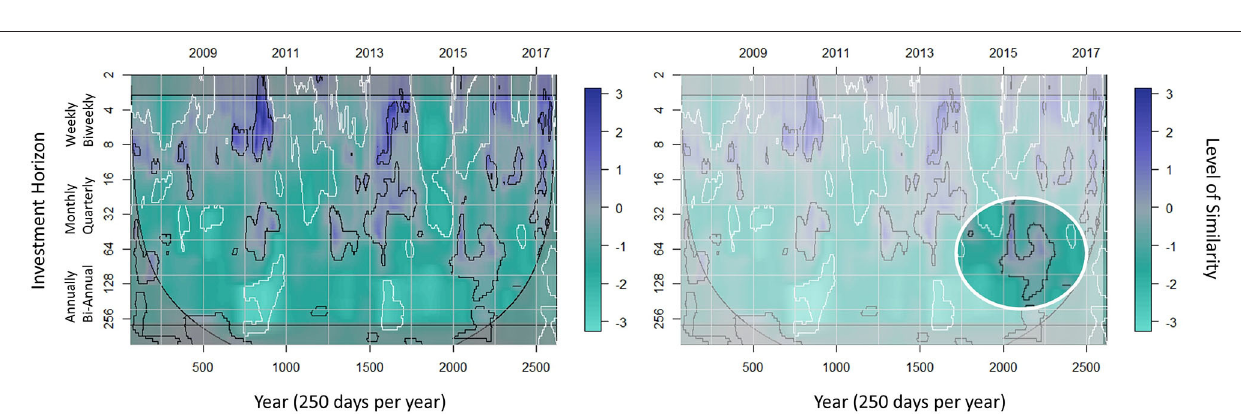
FIGURE 8 | Magnification of the WSD of the water-energy nexus from Figure 7 . The white circle emphasizes the WSD of the water-energy nexus during the quarterly investment horizon. The black-line regions are regions of statistical significance at the 5% level (high similarity). As we pointed out in section 2.3, the WSD is a difference equation so high similarity means values close to